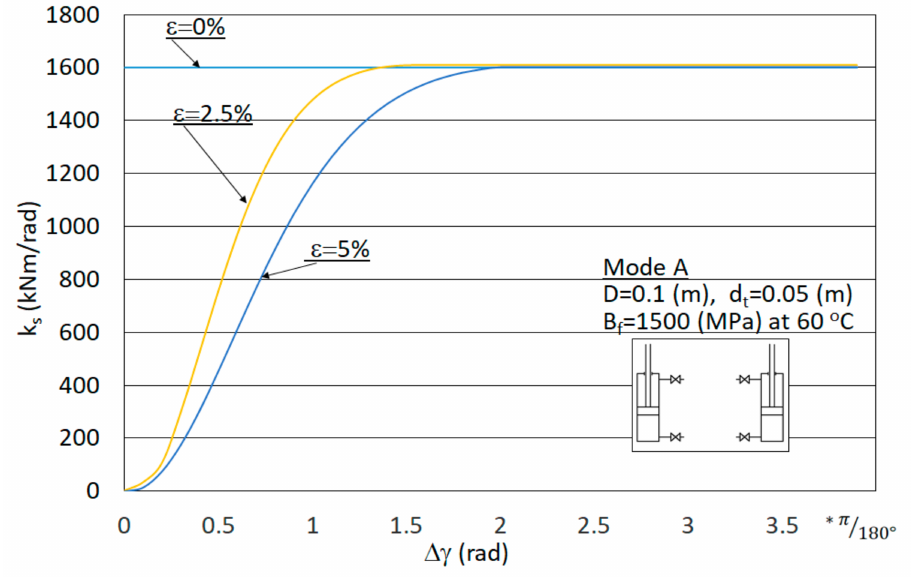
Figure 15. Results of calculations of the effective stiffness k s of the test machine’s steering system (mode A) without the flexible hydraulic hoses.